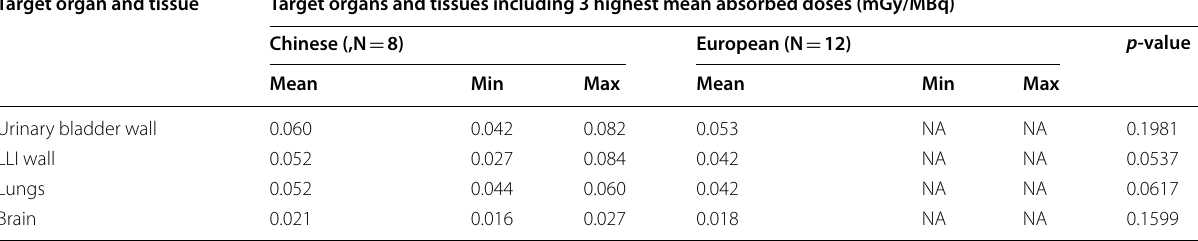
LLI lower large intestine; max maximum; min minimum; NA Not available; ULI upper large intestine. N Total number of subjects in the pharmacokinetic population for that cohort